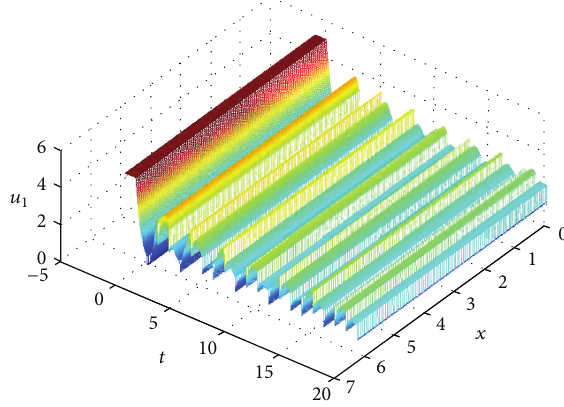
Figure 1: State response 𝑢1(𝑡, 𝑥) of model (44) without impulsive effects.